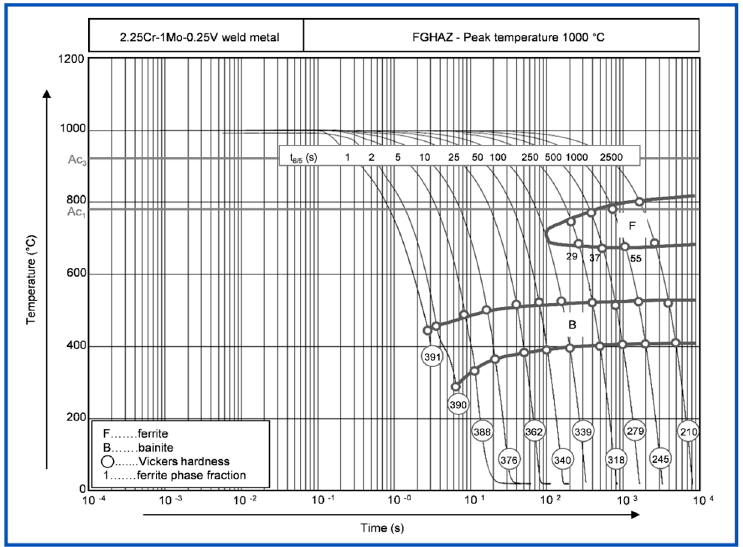
Figure 6. CCT diagram for the FGHAZ between the weld beads of a 2.25Cr-1Mo-0.25V multi-layer SAW all-weld metal with a peak temperature of 1000